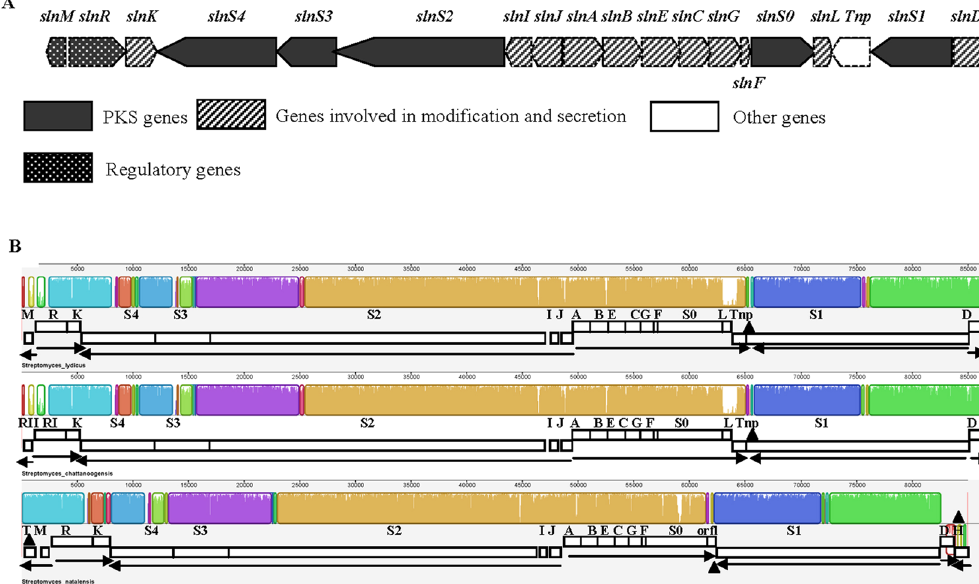
Figure 3. The natamycin biosynthetic gene cluster (BGC) of A02 ( A ) and comparison analysis of the natamycin BGCs of sln, scn and pim using the MAUVE program ( B ). The horizontal panels depict the sln (upper), scn (middle) and pim (lower) clusters. Mean sequence similarities are proportional to the heights of the red bars, and the respective scales show the sequence coordinates in base pairs. Regions with low similarities and strain- specific regions are marked with black triangles. Arrows indicate deduced transcriptional